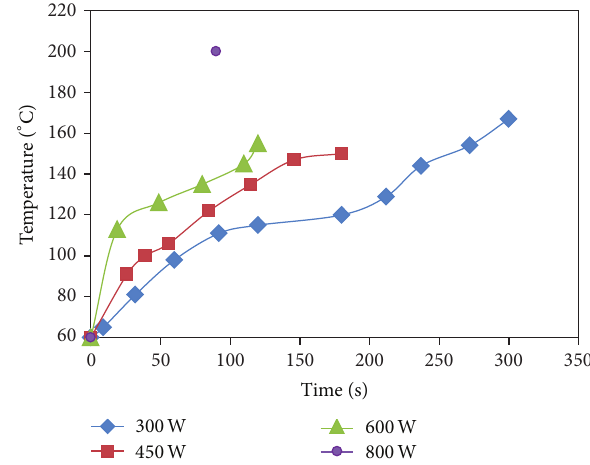
Figure 1: Temperature profile of phosphorylation of rice straw by microwave heating.